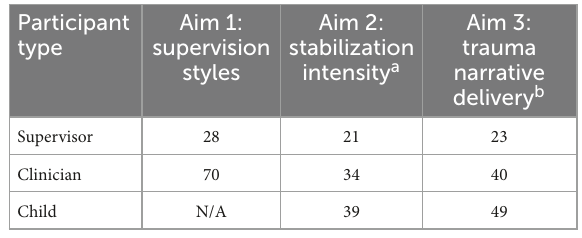
TABLE 1 Participant sample size in each